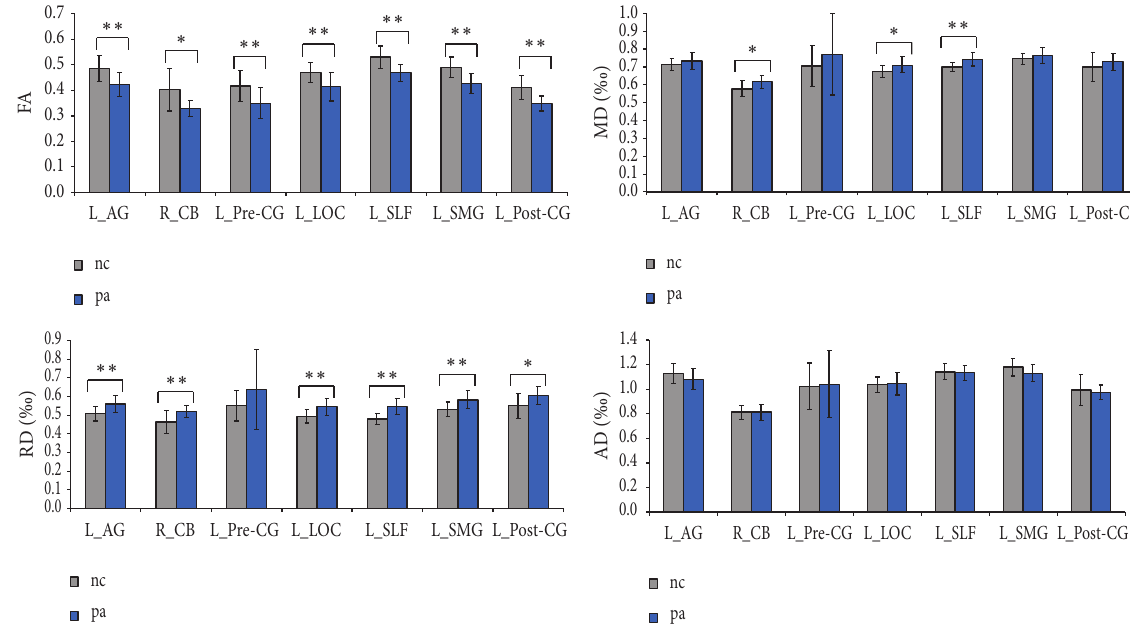
Figure 2: Differences in diffusion metrics between the SCI patients and healthy controls based on region of interest (ROI) analysis. The ROIs were extracted based on the findings of TBSS. ∗∗ represents statistical significance with FDR 𝑞 < 0.05 ; ∗ represents statistical significance with unadjusted 𝑝 < 0.05 . The error bar indicated standard deviation (SD). AG: angular gyrus, PreCG: precentral gyrus, LOC: lateral occipital region, SLF: superior longitudinal fasciculus, SMG: supramarginal gyrus, PostCG: postcentral gyrus, CB: cerebellar, FA: fractional anisotropy, MD: mean diffusivity, RD: radial diffusivity, AD: axial diffusivity.